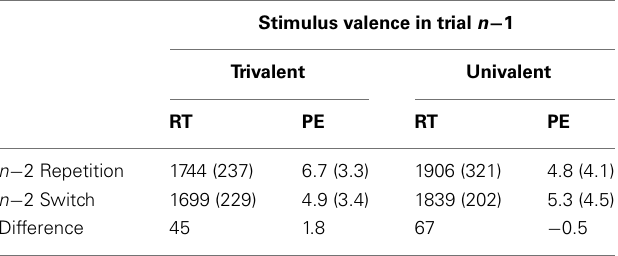
Table 1 | RT (SD) and PE (SD) in Experiment 1 for trivalent stimuli in trial n as a function of task sequence ( n − 2 repetition vs. n − 2 switch) and stimulus valence in trial n − 1 (trivalent vs.